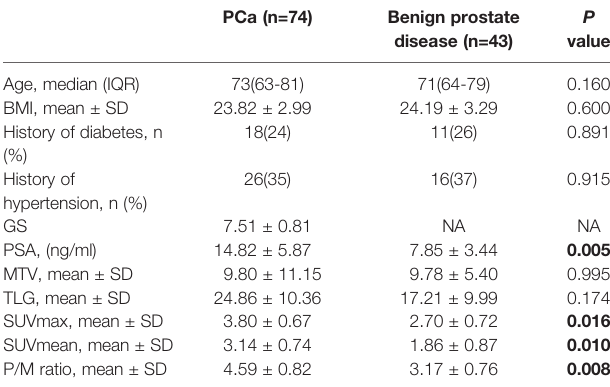
TABLE 1 | Clinical characteristics and 11 C-choline positron emission tomography and computed tomography (PET/CT) metabolic parameters of